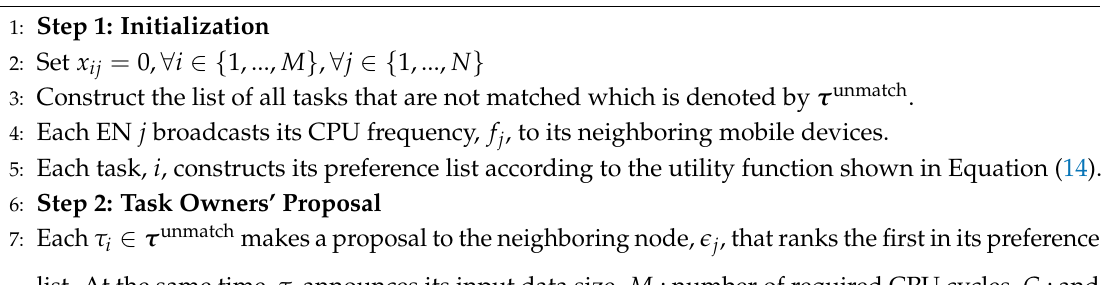
Algorithm 1 The proposed